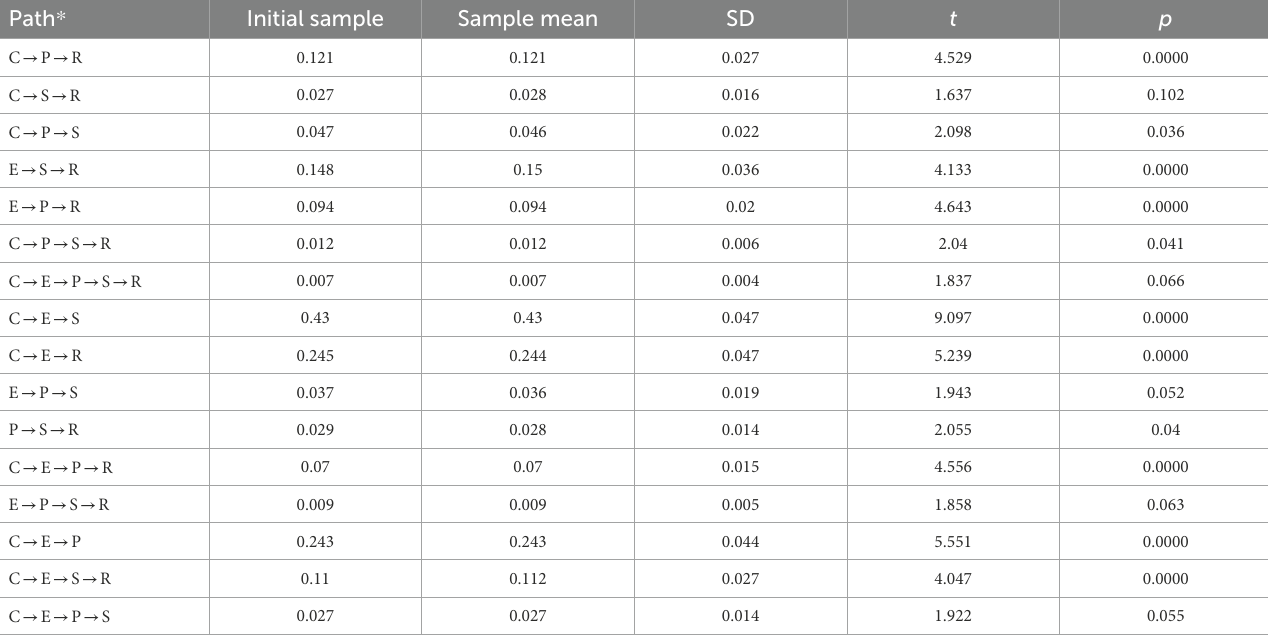
TABLE 6 Bootstrapping-specific mediating effect analysis.